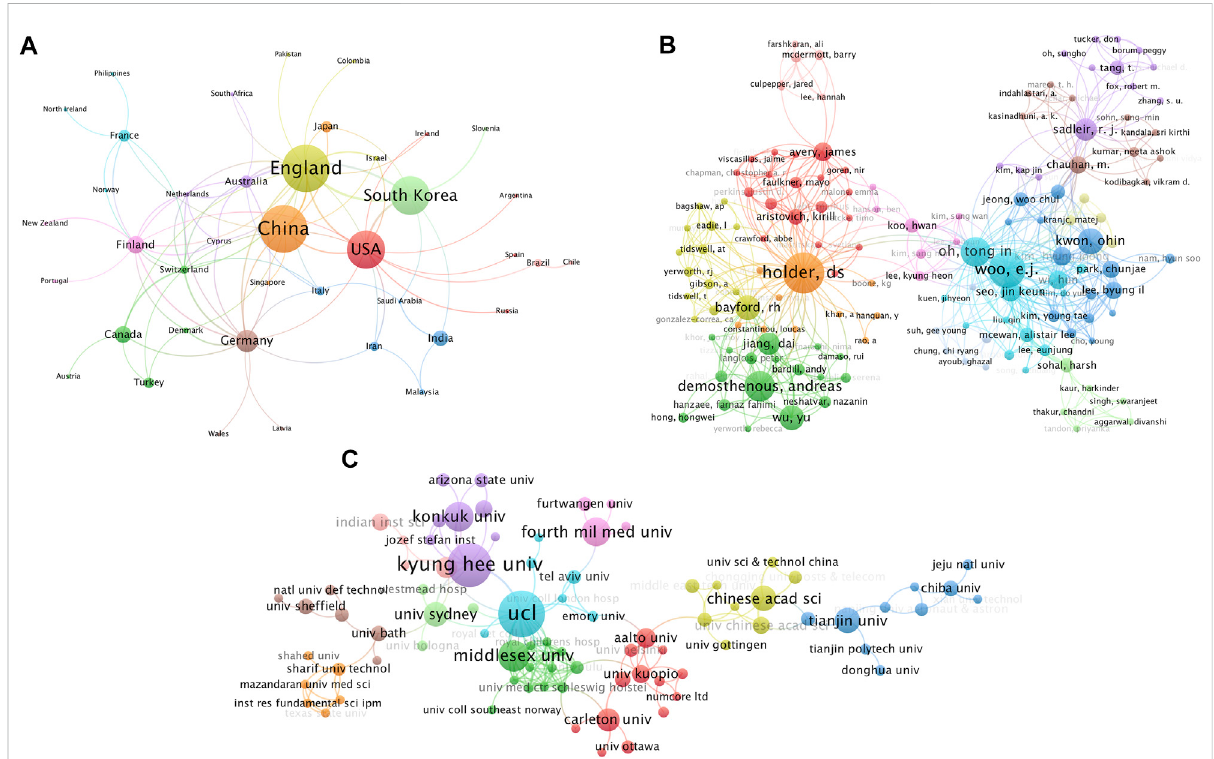
FIGURE 3 Cooperation of countries (A) , authors (B) , and institutions (C) on electrical impedance tomography hardware research from 1989.01.01 to 2021.12.31. The different colors represent countries (A) , authors (B) , and institutions (C) ; color plate size indicates the number of publications, respectively; line thickness indicates the strength of